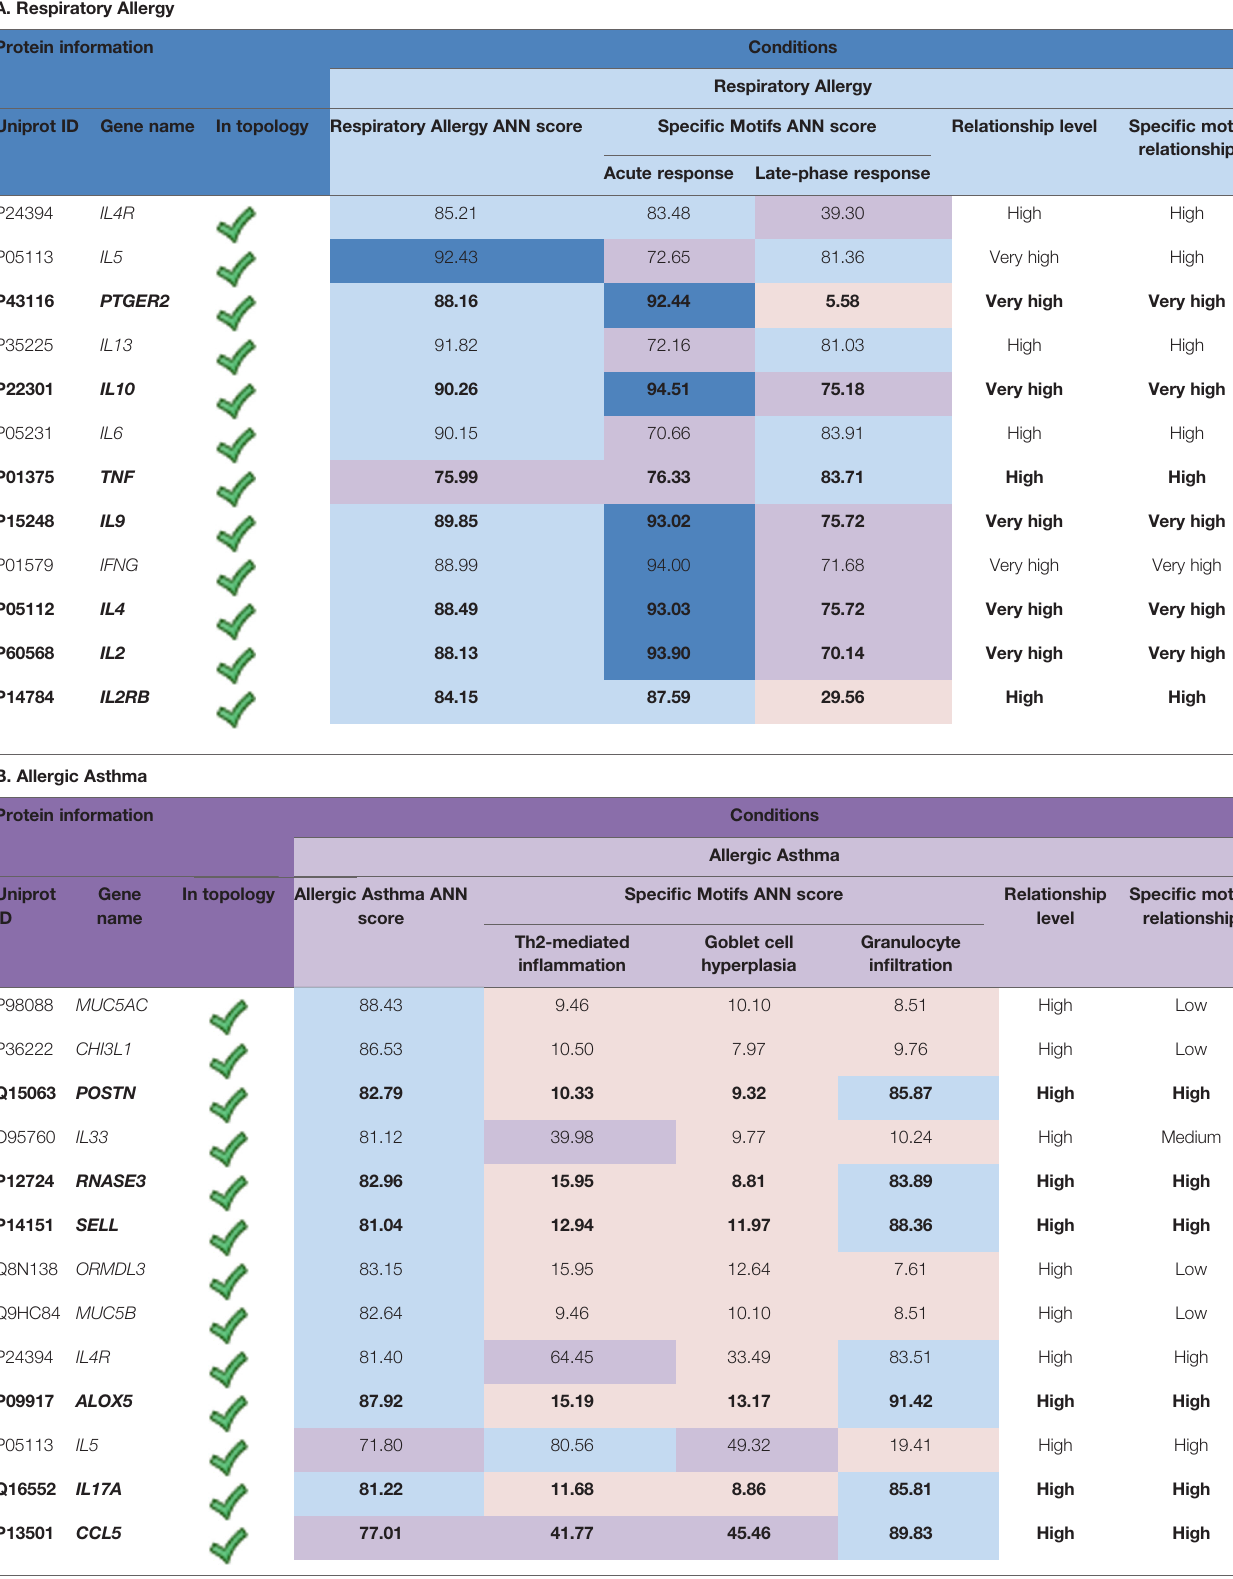
TABLE 5 | Speci fi city ranking of the proteins with a high relationship to at least one of the studied conditions (overall disease and/or molecular